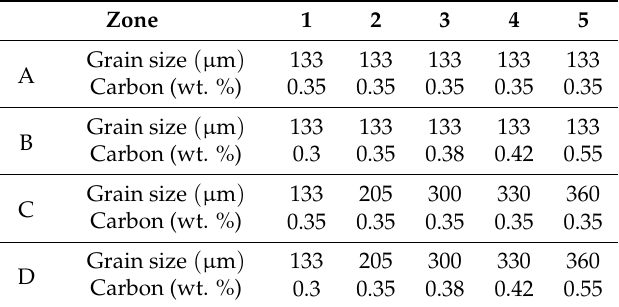
Table 3. The initial austenite grain size and carbon concentration specified for different zones corresponding to the simulation